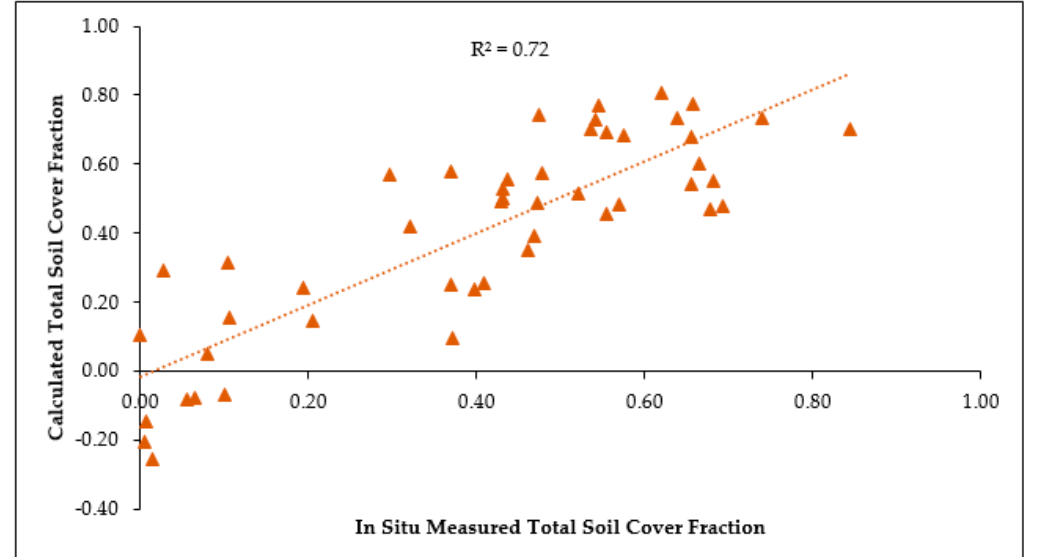
Figure 6. Comparison of total soil cover calculated from linear relationships for separate residue and green cover (Figure 5) and in situ residue and green cover data summed together. Data from the 18/30 2016-04-18 image ( n = 49). Table 8. Individual image accuracy results for linear regression (point fractions) and confusion matrix (fraction classes) for unmixing residue and green cover fractions (using corn residue + green cover + bare soil endmembers) and calculated total cover compared to in situ measures, respectively.